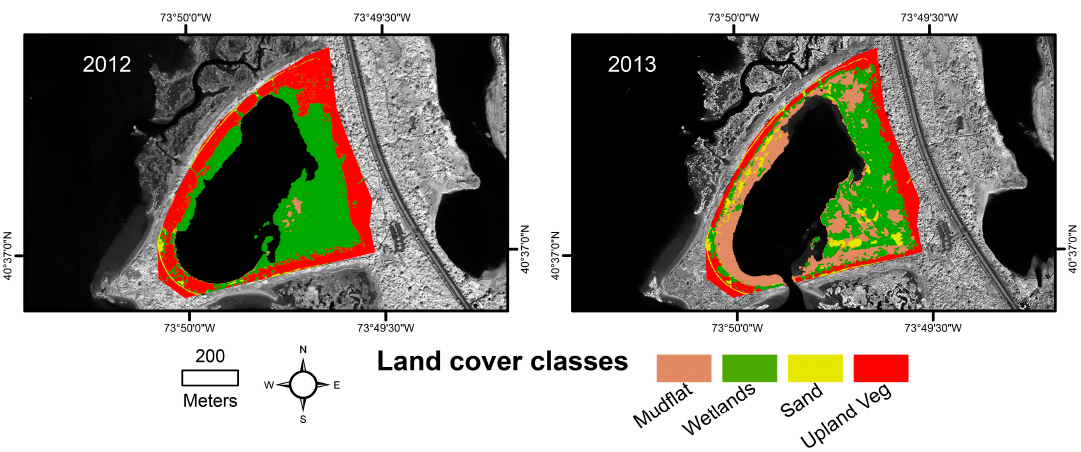
Figure 4. Vegetation change from 2012 to 2013 of the West Pond area.